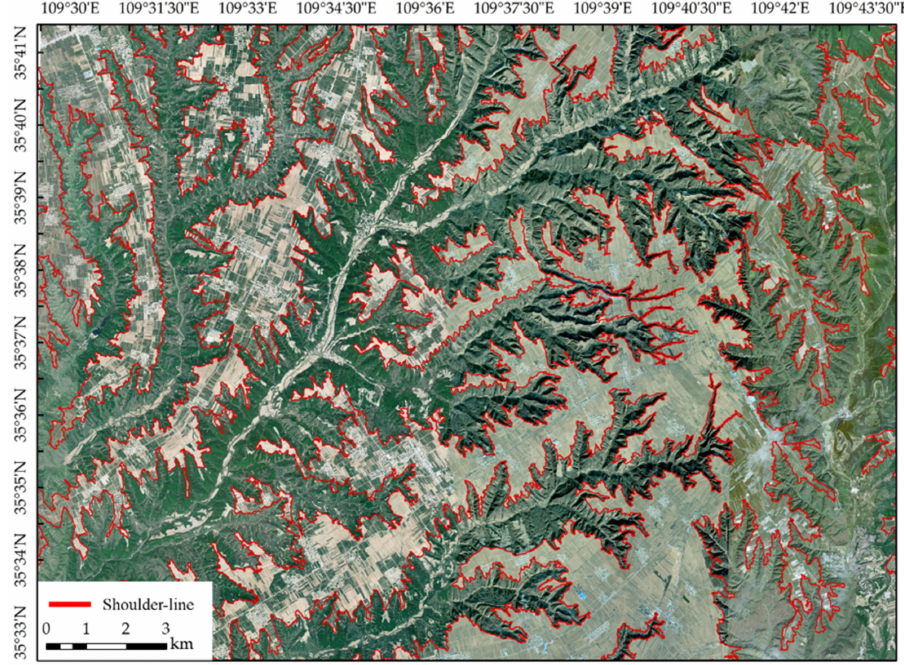
Figure 15. Shoulder lines extracted by applying the method proposed in this study. In loess ridge and hill regions, the terrain was more complex. As shown in Figure 16, there were many seriously discontinuous shoulder lines due to occasional gravity erosion factors, such as landslides and scattering. Some areas were also affected by artificial land- forms, such as terraced fields, dams, etc., resulting in the existence of multilevel shoulder lines (Figure 16a). At the same time, in loess ridge and hill regions, due to the influence of vegetation, the slope of the shoulder line’s up- and down-slopes showed little change, and there were invisible shoulder lines (Figure 16b,c). Even if there is no interference from vegetation, in autumn and winter the continuity and visibility of shoulder lines are poor due to the impact of gravity, such as landslides, strays, and collapses, or even human factors (Figure 16d). Therefore, the application of this method in loess ridge and hill areas is also a problem that needs to be discussed and solved in the future. In future research, it is necessary to further analyze the applicability of this method for different data sources and different landform types. To better apply the method to different landform types over a large area, we could try to divide different areas according to the different land use characteristics (soil erosion characteristics and land use directions) of each landform type. the high-efficiency and high-precision extraction of shoulder